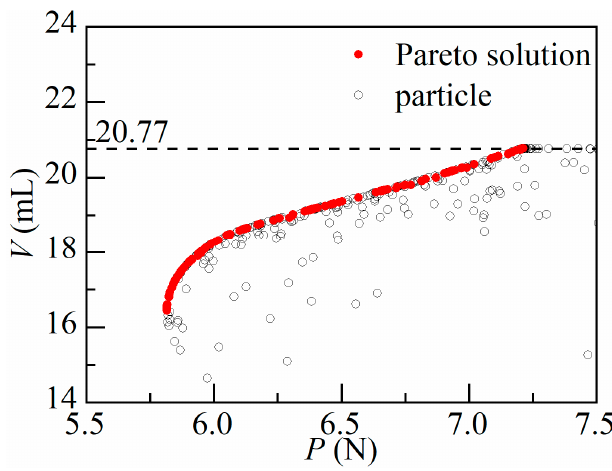
Figure 10. Pareto solutions of MOPSO algorithm.